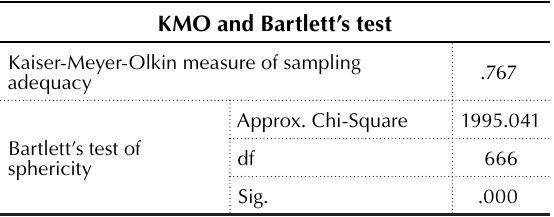
Table 2. Results of KMO and Bartlett’s test of sphericity on barriers to effective VCM KMO and Bartlett’s test